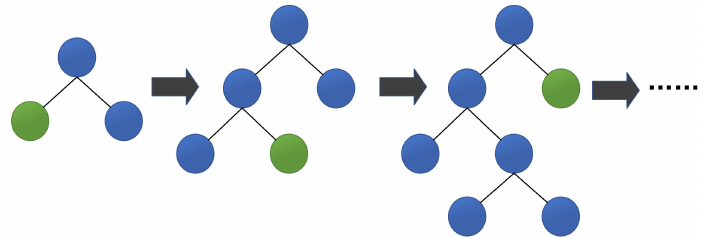
Figure 2. Leaf-wise tree growth strategy.